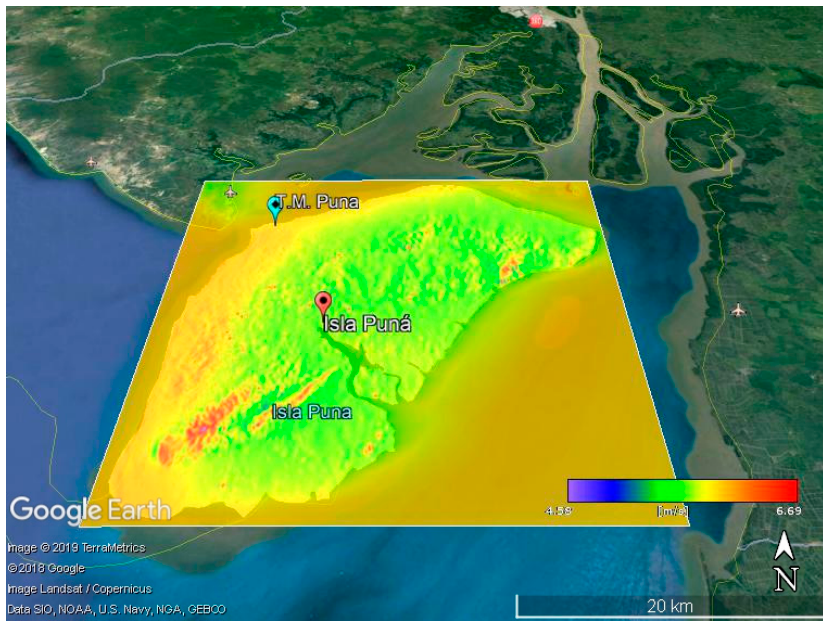
Figure 15. Contour line and isotach map of Puná Island.